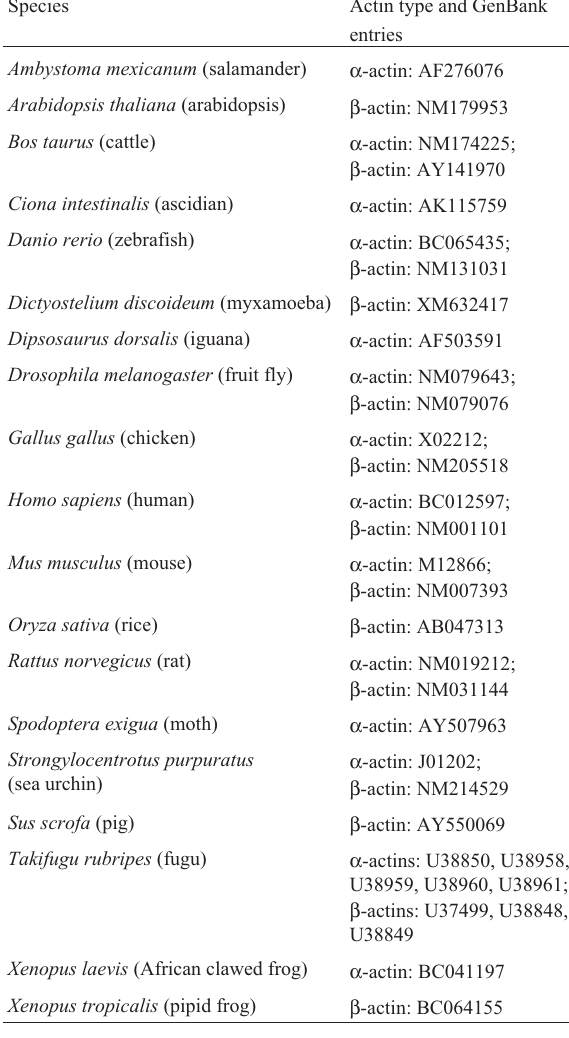
Table 1 - Species and accession numbers of actin cDNA sequences ob- tained from GenBank. Species Actin type and